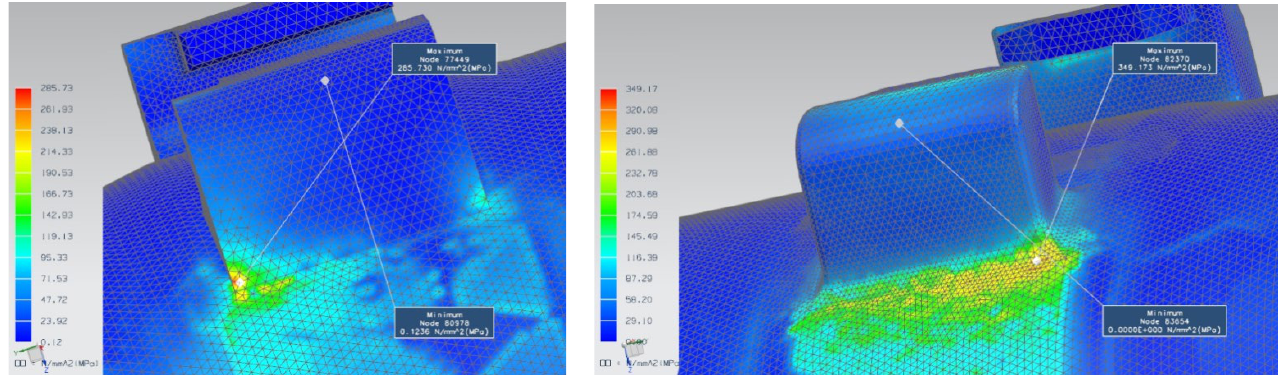
Figure 3. Simulation analysis of the vibration stress distribution.